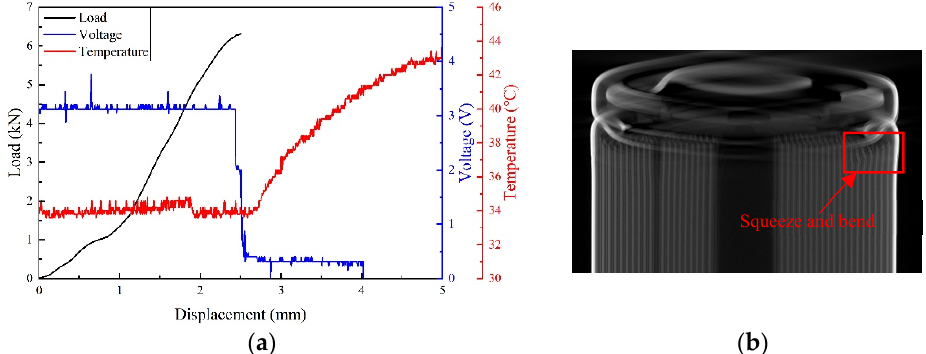
Figure 9. ( a ) Load, voltage, and temperature–displacement curve for the first voltage drop; ( b ) CT scan.